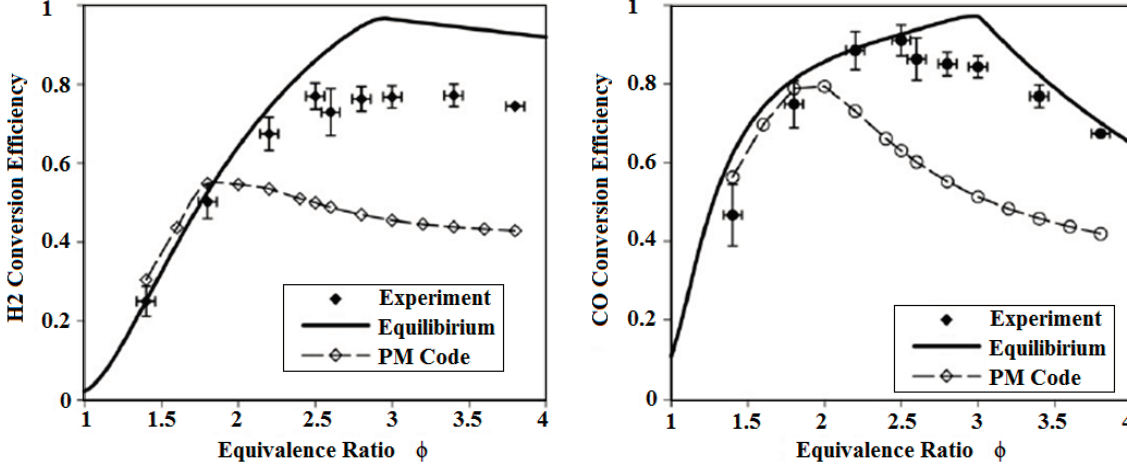
Figure 14. H and CO conversion efficiency against equivalence ratio 2